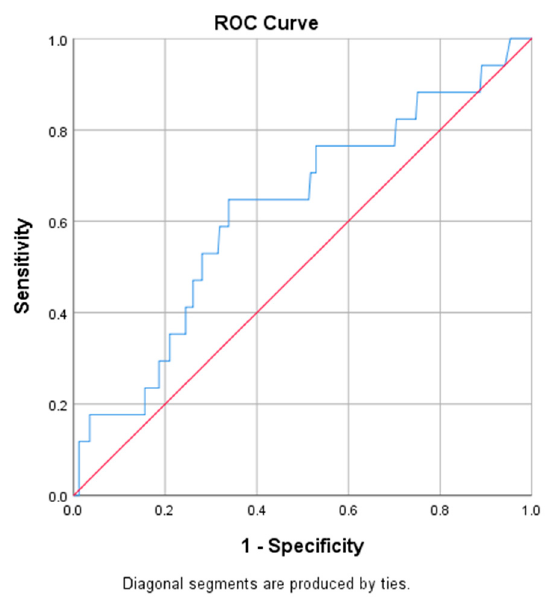
Figure 3. Heart Failure: REI ROC curve.